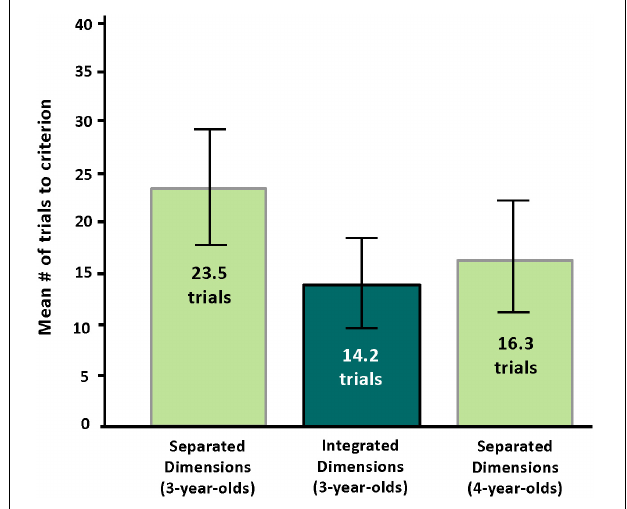
FIGURE 4 | Mean Number of Trials to Criterion on Block 3 of Conditional Discrimination by Age and Condition in the present study.